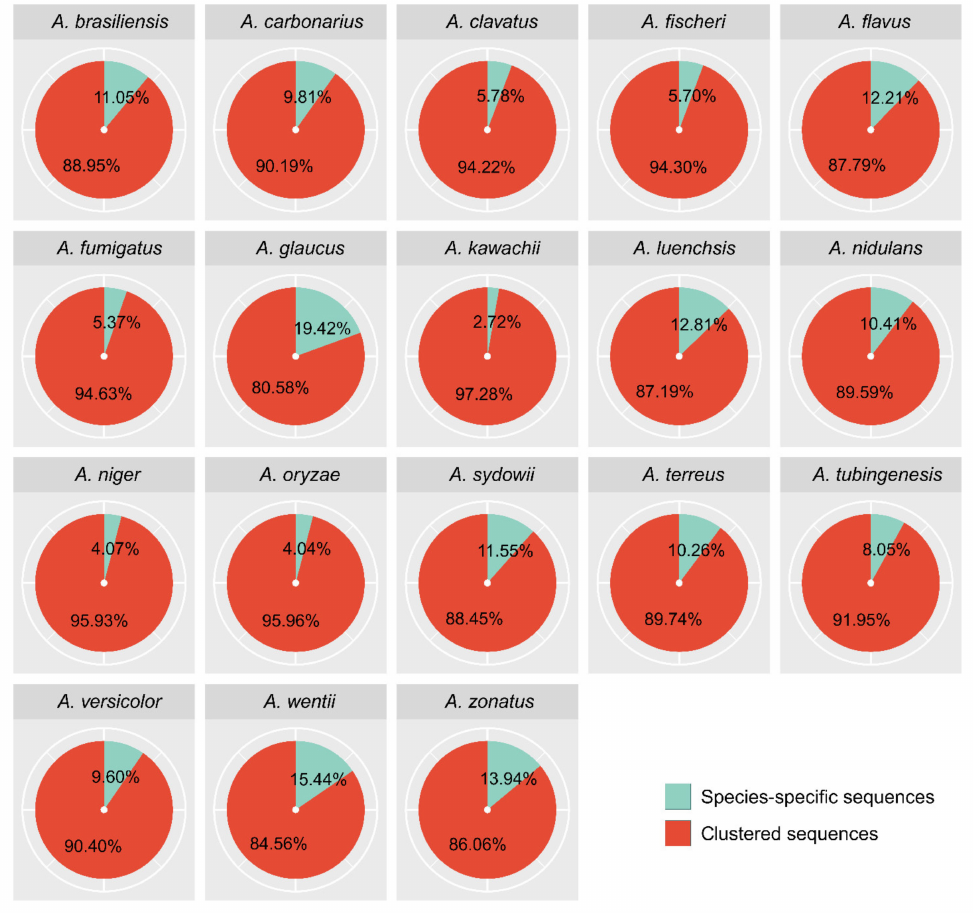
Figure 2. Distribution of Aspergilli proteins as unique or shared relative to the entire set of proteins. Partitioning Aspergilli gene sets by their traceable orthology reveals a spectrum of conservation from widespread orthologues found across the Aspergilli to species-specific genes with no recognizable homologues. The pie chart shows the percentage of unique and conserved proteins coded among all eighteen sequenced Aspergilli identified by OrthoMCL analysis. Species-specific sequences include both the singletons and the same species’ inparalog